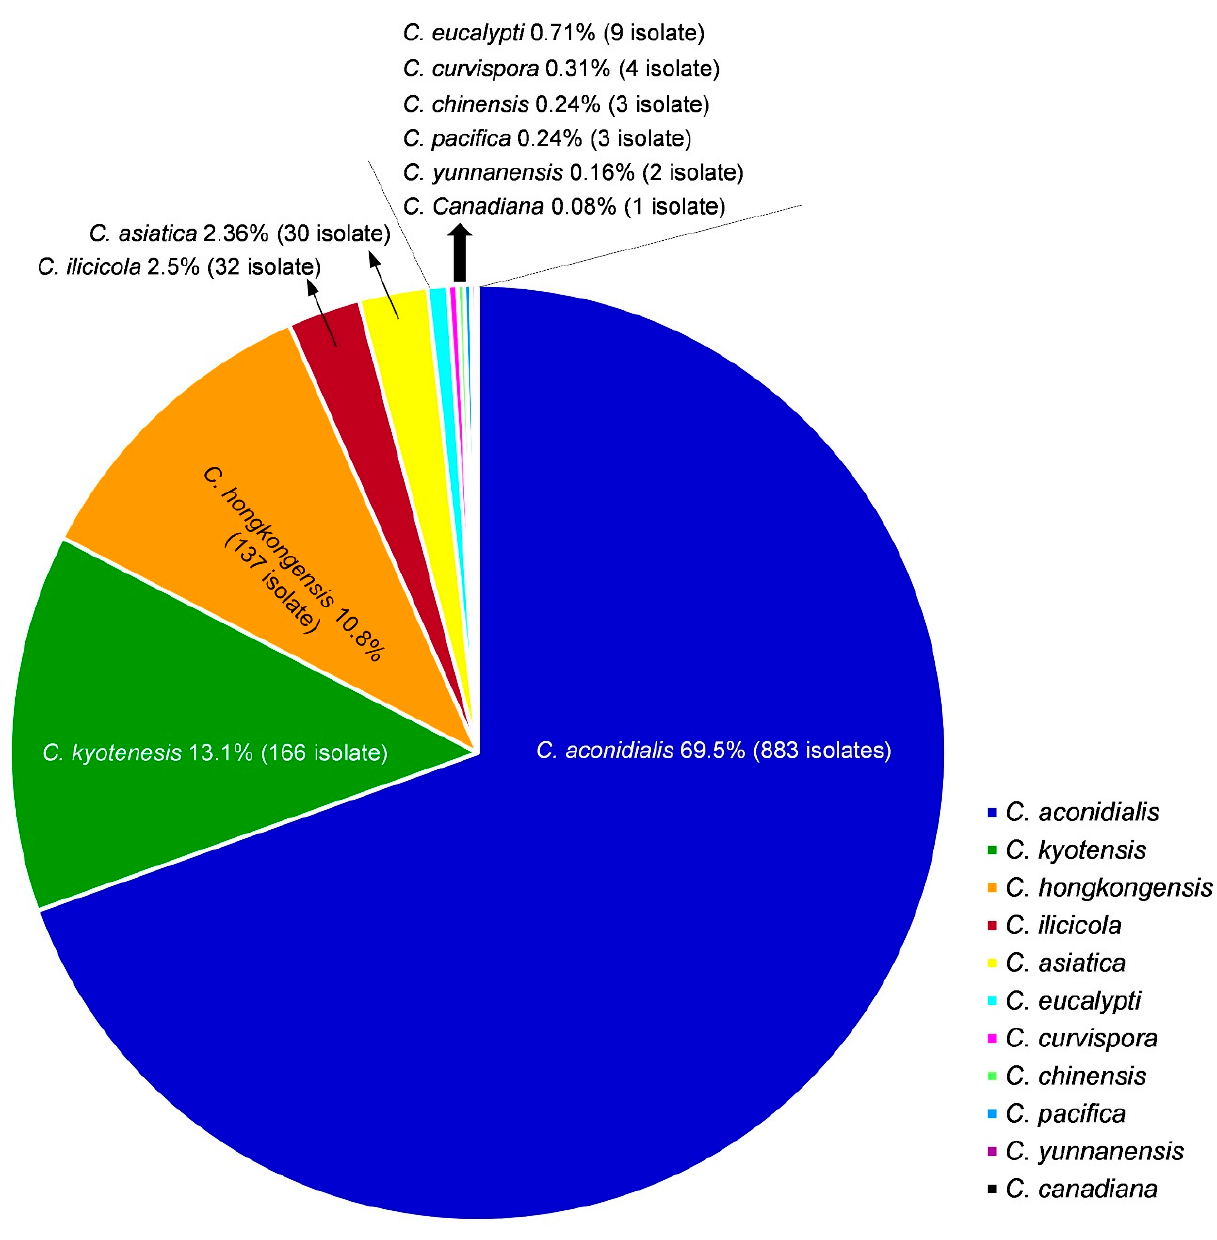
Figure 5. Percentage of each Calonectria species obtained from all sampling sites in this study. Different Calonectria species are indicated by numbers with di ff erent colors.